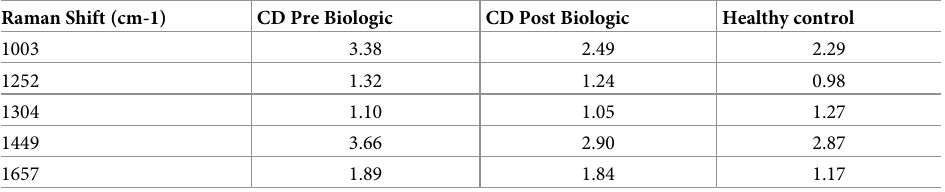
Table 6. Relative intensity of Raman shifts between CD pre-biologic and post-biologic and HC taken from